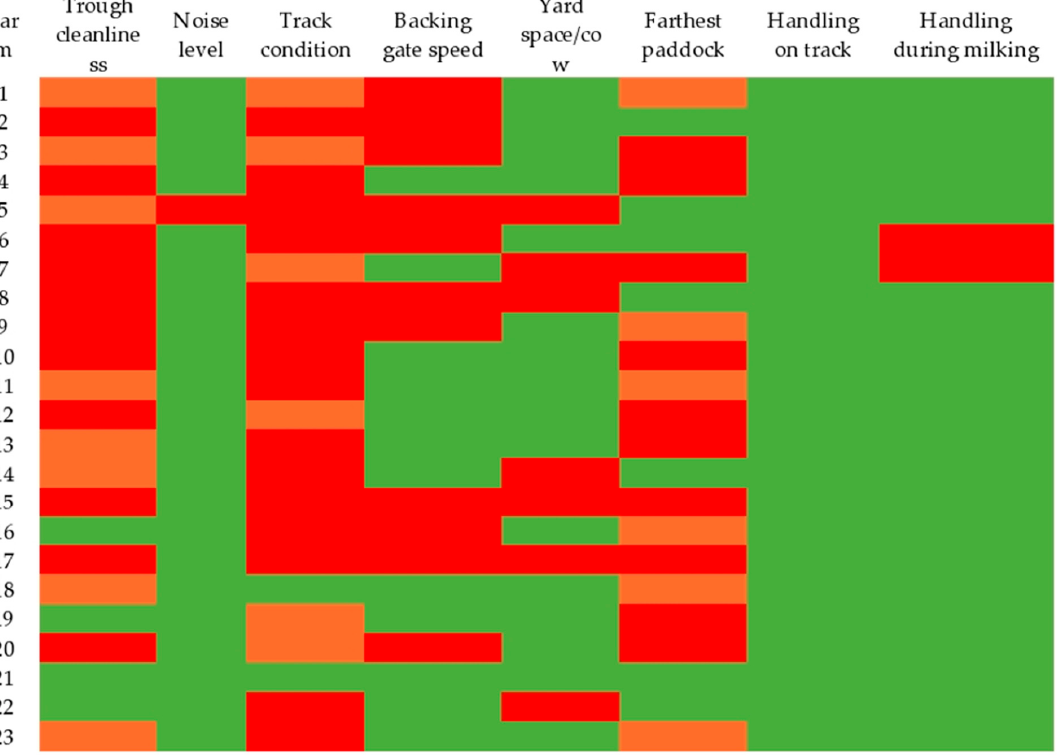
Figure 2. Heatmap representing welfare levels for six resource-based measures and two handling measures. All measures had three welfare levels (acceptable, green; marginal, orange; or unacceptable, red), except for yard space, backing gate speed, and the two handling measures which had two levels (acceptable, green; unacceptable, red). See Table 2 for further details of measurements and